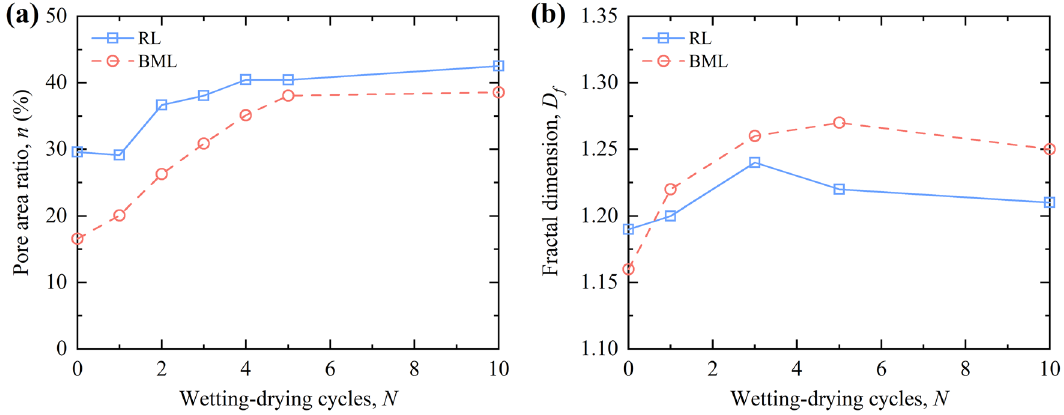
Figure 8. Variation of pore area ratio ( n ) and fractal dimension of loess under W–D